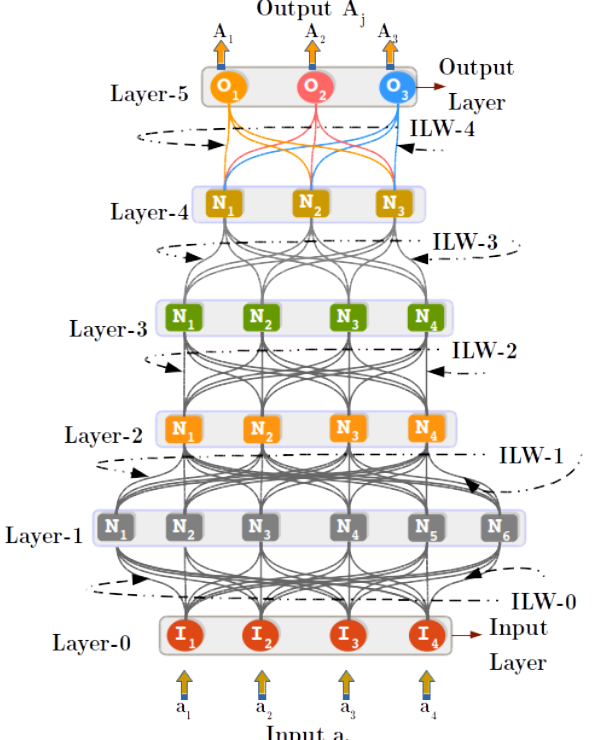
Figure 7. The model generated with 90% stratified IRIS data using Concept Hierarchy Creation (CHC) algorithm. Layer-0 is created while initializing the CHC algorithm. The algorithm grew to a Desired-depth of six Layers (including input Layer-0), and in each iteration of the CHC algorithm a new layer is created dynamically and the interlayer weights (ILW) are learned between the existing layer and a newly created layer above